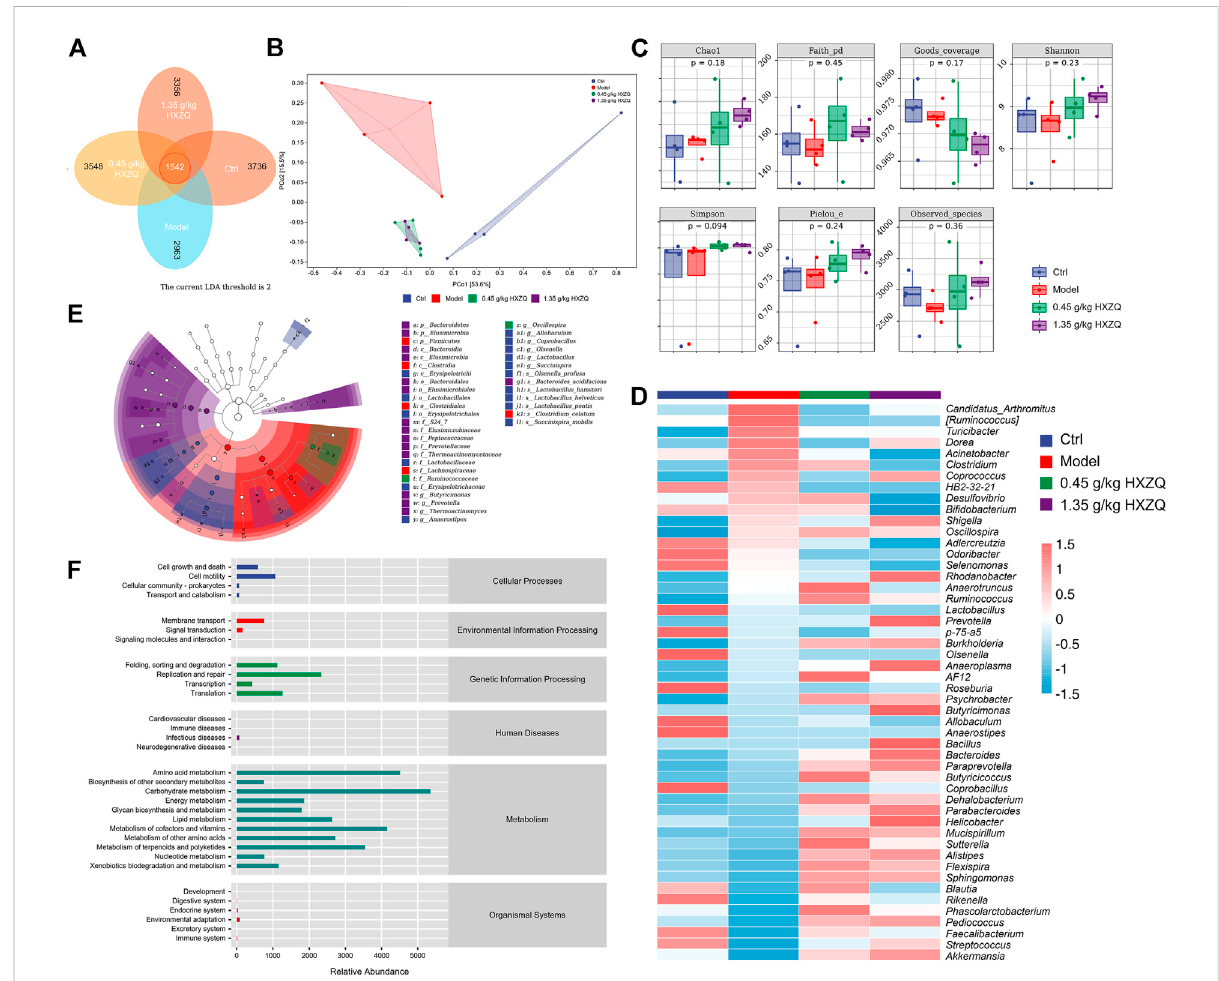
FIGURE 2 The effect of HXZQ on the intestinal microbiota of AOM/DSS mice ( n = 4) (A) Venn diagram. (B) PCoA of weighted UniFrac distance from beta diversity analysis. (C) Grouping box plot of alpha diversity index includes Chao1, Faith_pd, Goods_coverage, Shannon, Simpson, Pielou_e, and Observed_species of intestinal microbiota. (D) Heatmap of the top 50 dominant species composition at the genus level. (E) LEfSe analysis of the dominantbiomarkertaxaamongthefourgroups.ThethresholdofthelogarithmicscoreofLDAanalysiswas2.0. (F) Predictedabundancegraph of KEGG metabolic